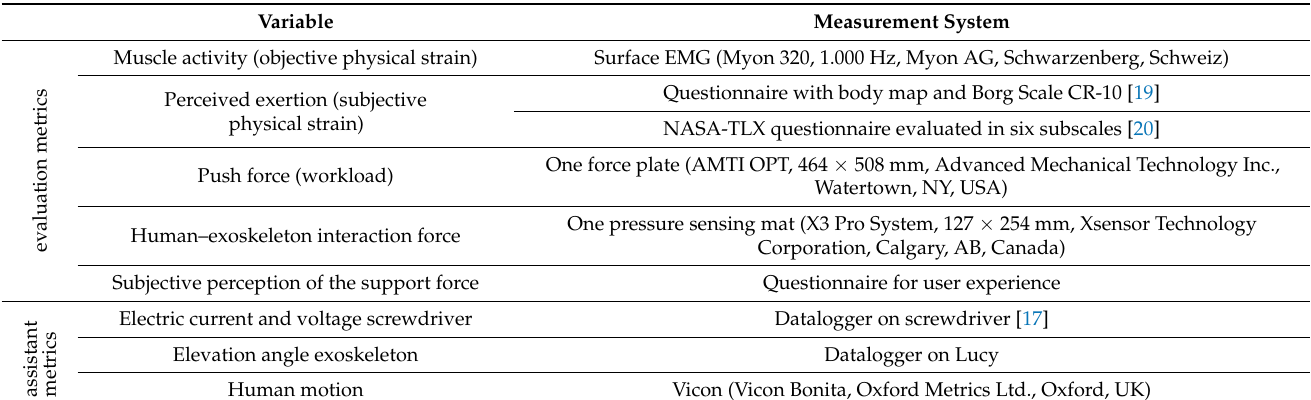
Table 3. Variables and measurement systems.